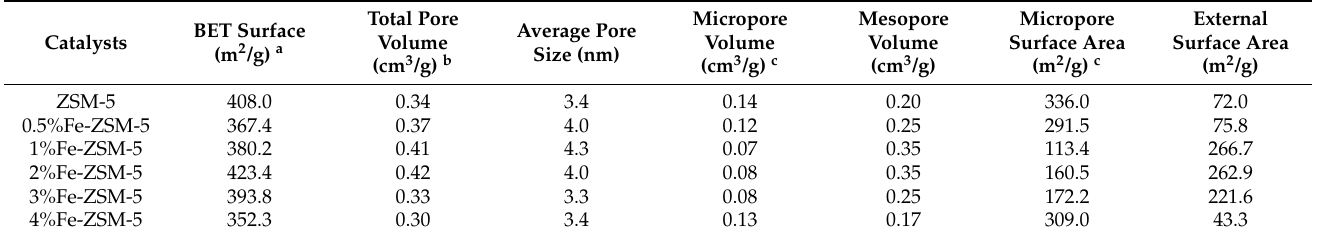
Table 1. The BET surface area, pore volume, and pore size of different catalysts.